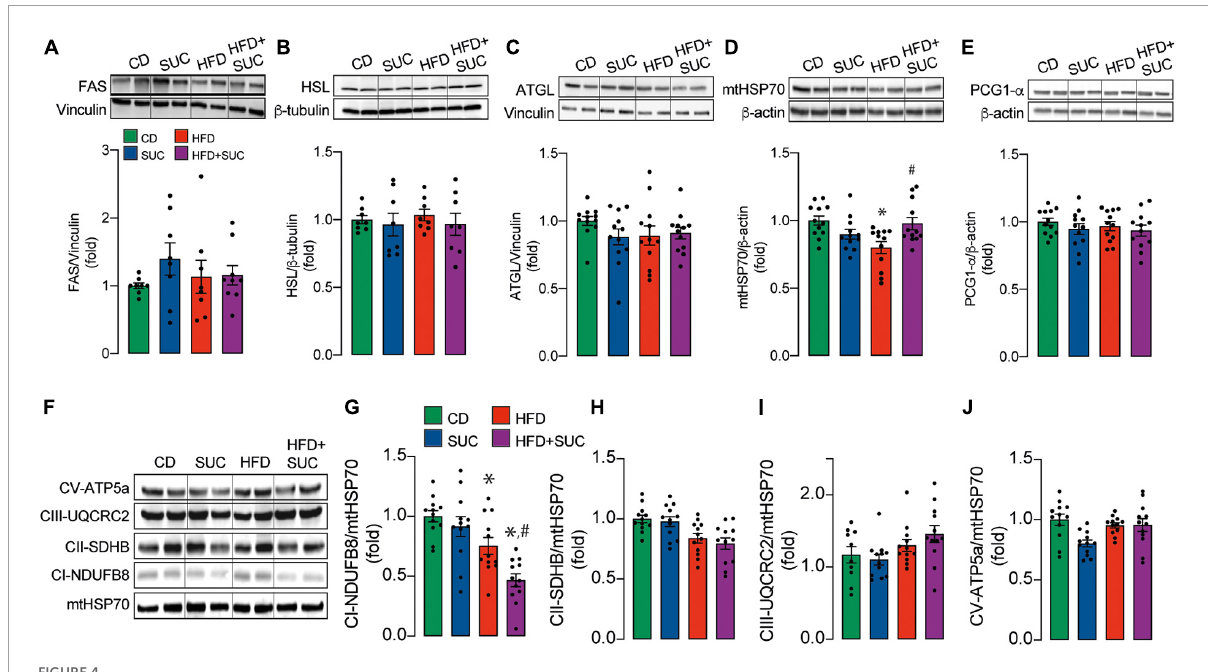
FIGURE4 Effect of sucralose on mitochondrial mass and biogenesis. Western blot. Representative image and analysis of the densitometry of the: (A) FAS. (B) HSL. (C) ATGL. (D) mHSP70. (E) PGC1- α . (F) Representative image of mitochondrial complexes. (G) Complex I. (H) Complex II. (I) Complex III. (J) Complex V. n = 6–8 mice per condition. Two-way analysis of variance (ANOVA) followed by Holm-Sidak’s post-hoc test. Values are expressed as mean ± SEM. * p < 0.05 vs. CD; # p < 0.05 vs.